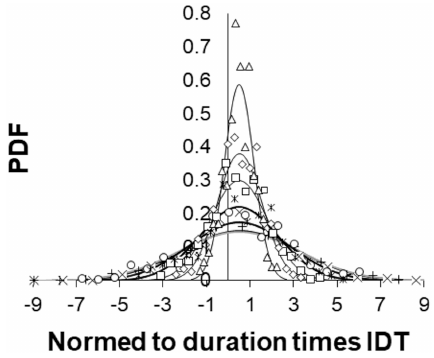
Figure 6. PDF of, normed to window length, IDT values calcu- lated for consecutive 100 data windows of simulated noise data se- quences, shifted by 100 data. From top to bottom, black curves cor- respond to β = 0 . 001 (triangles), β = 0 . 275 (diamonds), β = 0 . 545 (squares), β = 0 . 810 (asterisks), β = 1 . 120 (circles), β = 1 . 387 (plus signs), and the grey curve corresponds to β = 1 . 655 (cross